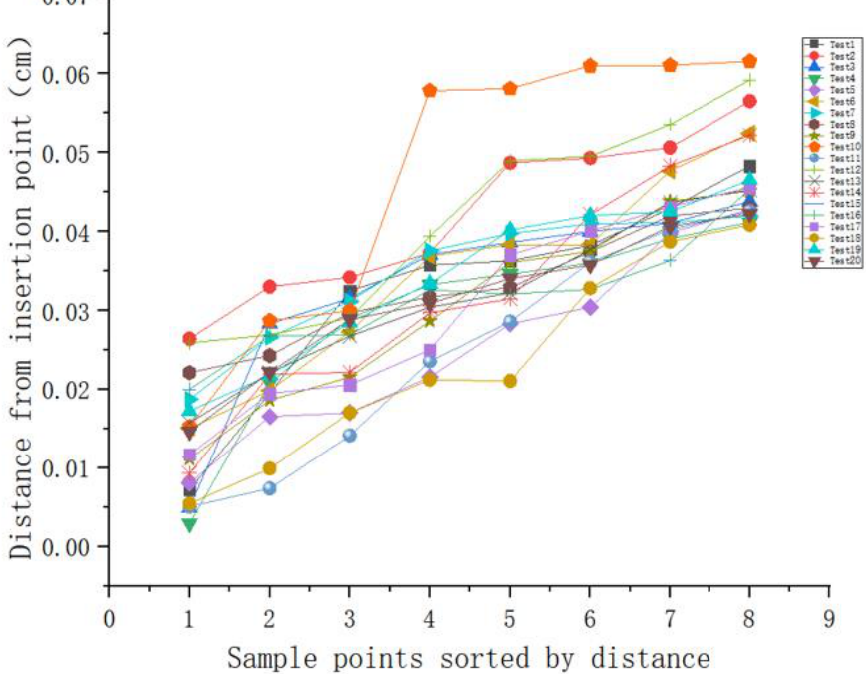
Energies 2021 , 14 , x FOR PEER REVIEW Figure 10. Distance between the insertion point and the point in sample space V.